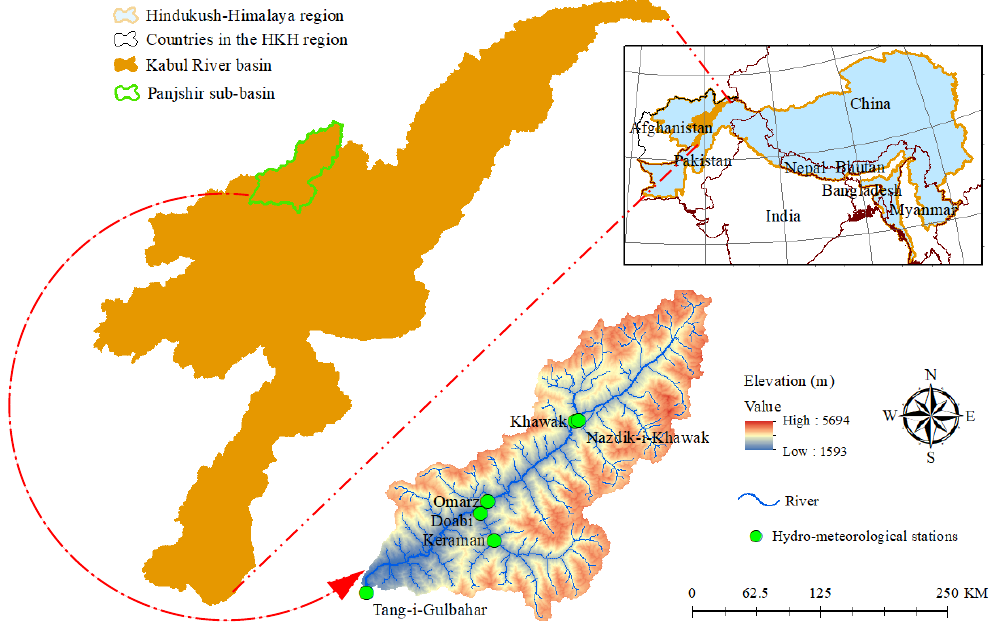
Figure 1. The Panjshir sub-basin of the Kabul River basin and the HKH region.